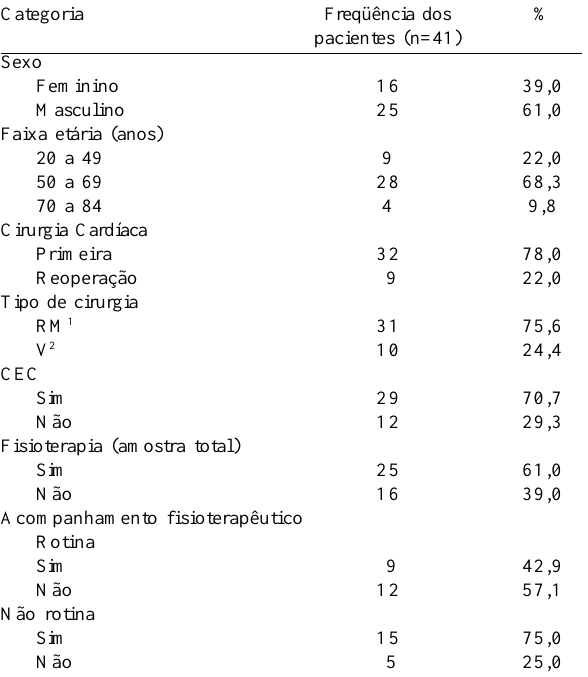
Tabela 1. Características gerais dos 41 pacientes que realizaram cirurgia cardíaca eletiva, no período de junho de 2002 a março de 2003, no serviço de cirurgia cardíaca do HC- FMB/UNESP.